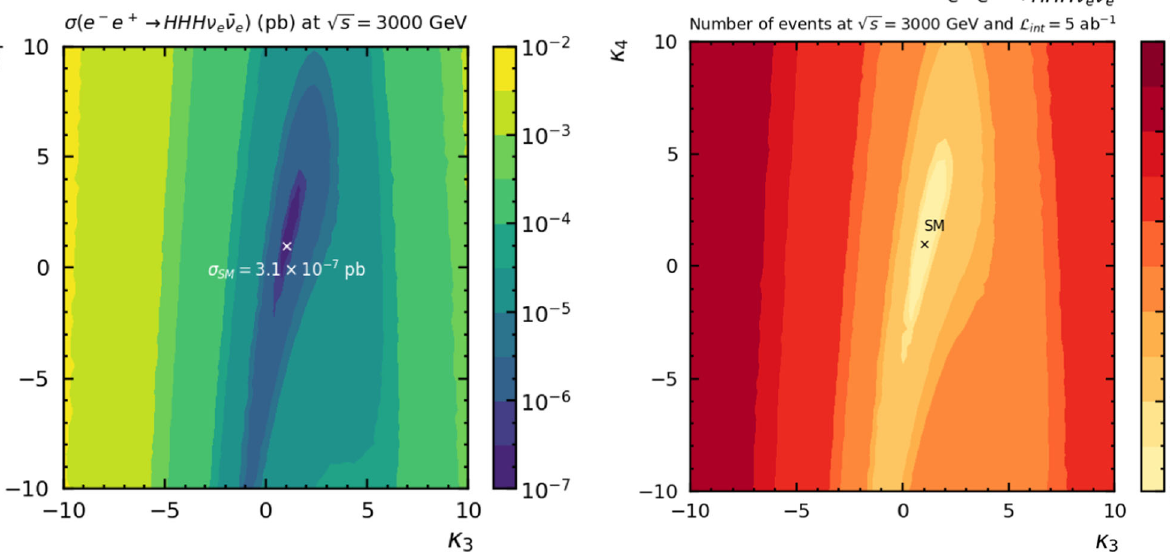
Fig. 27 Left: contour levels for the total cross section of the e + e − → H H H ν e ¯ ν e process represented in the (κ 3 ,κ 4 ) plane at a CM energy of 3000 GeV. Right: corresponding contour levels for the number of e + e − → H H H ν e ¯ ν e events expected at the last stage of CLIC with L int = 5 ab −